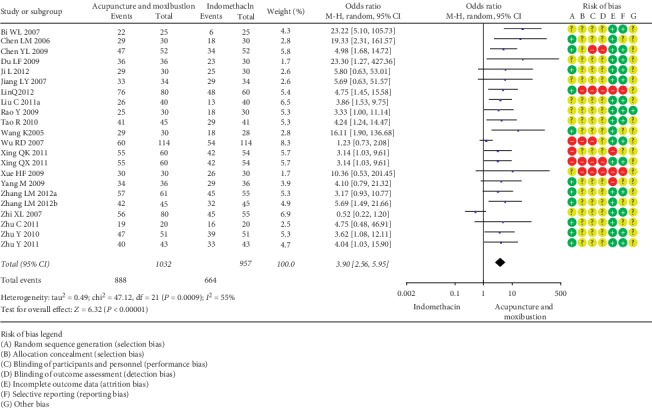
Acupuncture and moxibustion vs. indomethacin.